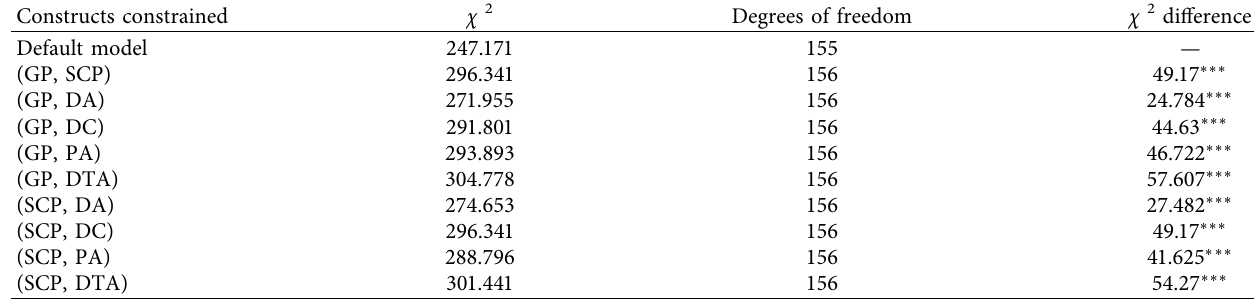
Table 2: Discriminant validity.